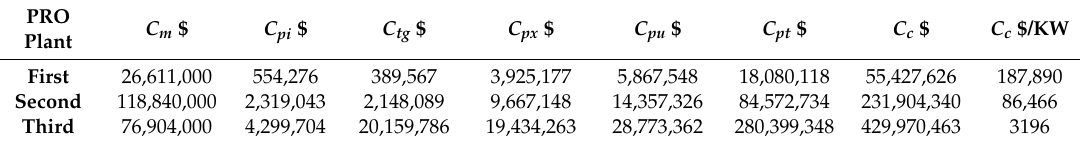
Table 7. Cost calculations of the three PRO power plants.